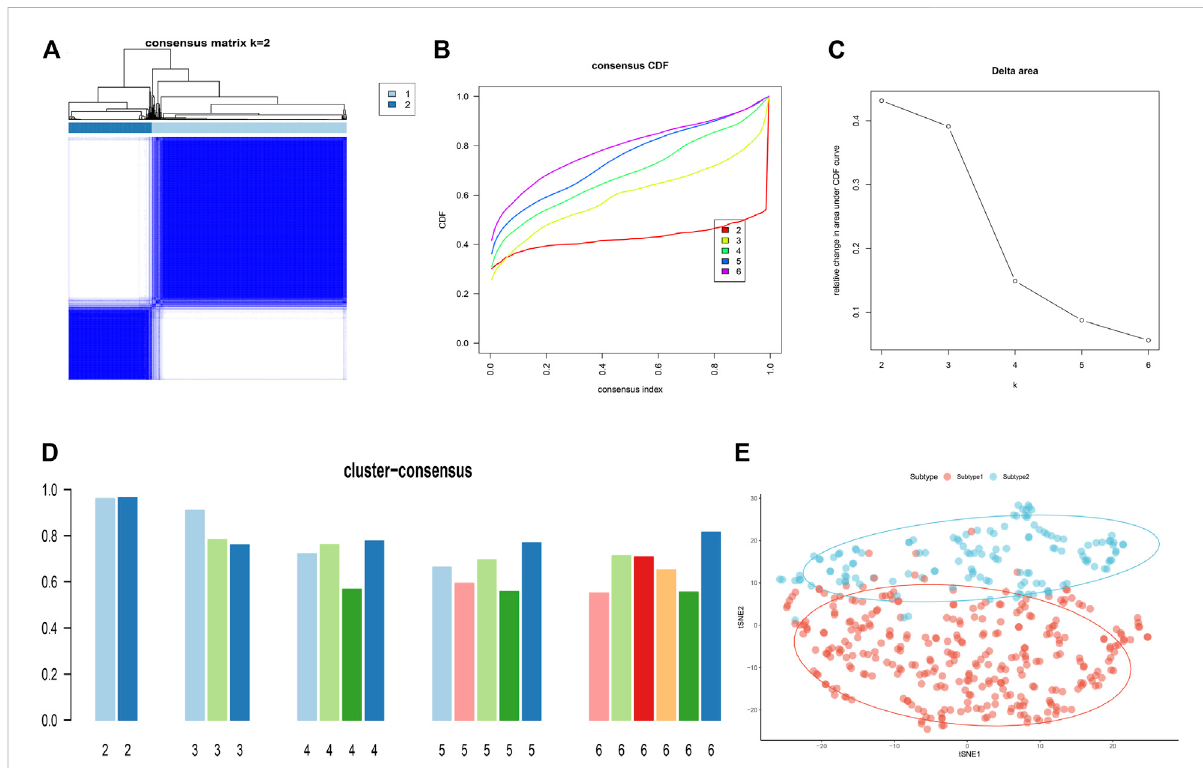
FIGURE 9 Identi fi cationofERstress-relatedmolecularpatternsinAD. (A) Consensusclusteringmatrixwhenk=2. (B – E) RepresentativeCDFcurveswhen k =2to6. (C) RelativealterationsinCDFdeltaareacurves. (D) Consensusscoreineachsubtypewhen k =2to6. (E) t-SNEdiagramdemonstratesthat the AD patients are classi fi ed into two distinct